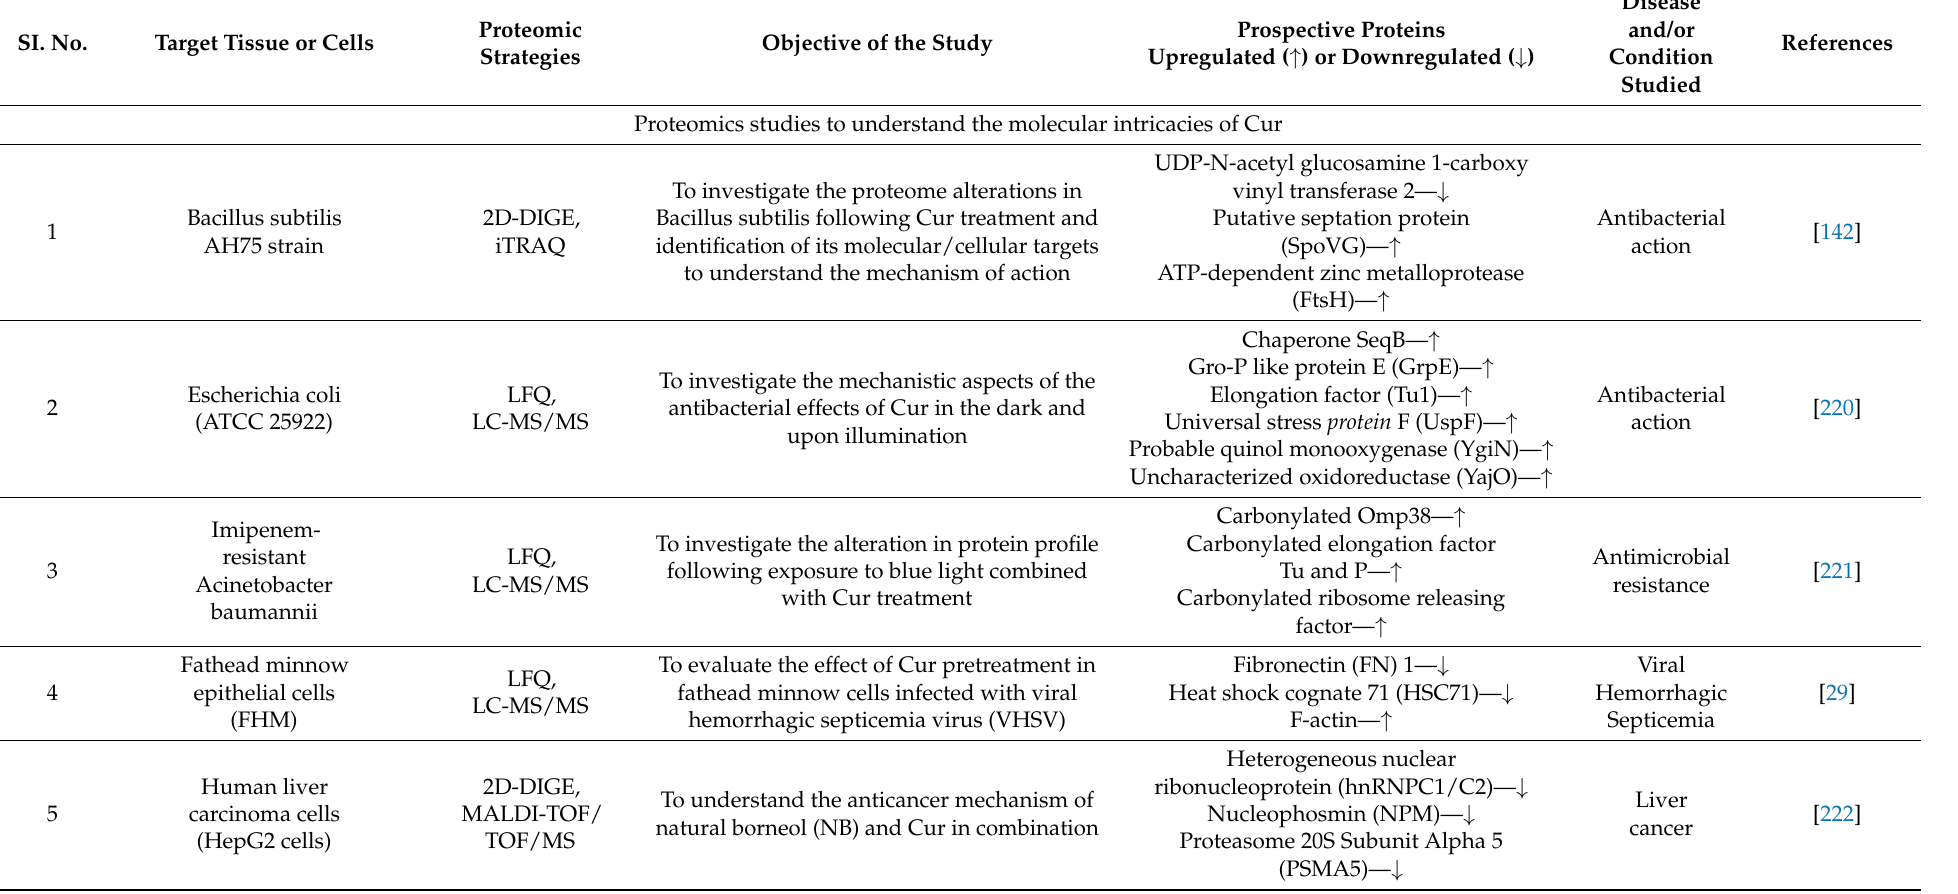
Table 2. Representative table providing an overview of various proteomics studies to understand the potential role of Curcumin, Genistein, and Tanshinone IIA against various disease